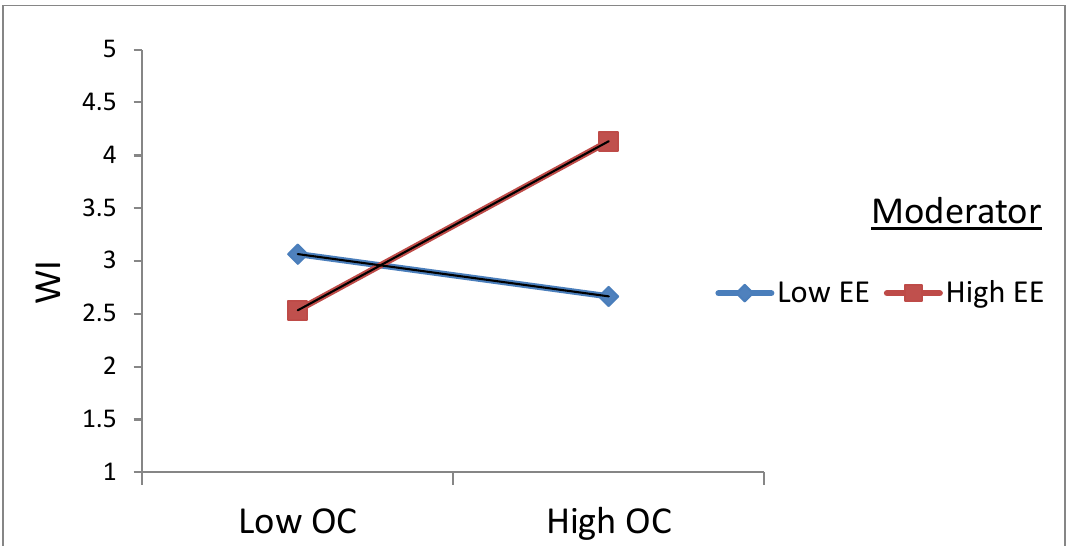
Figure 2. Interaction plot between organizational change and emotional exhaustion on workplace incivility.